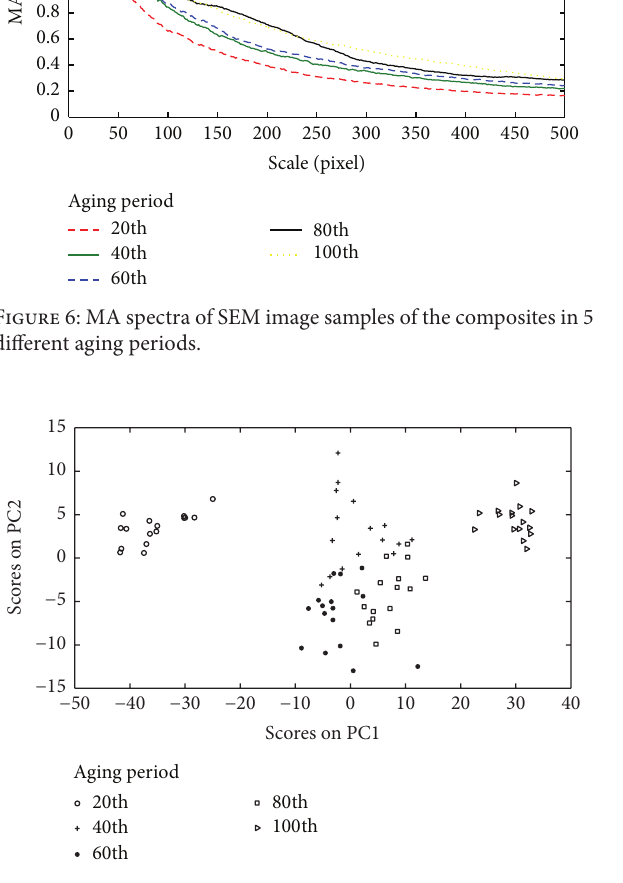
Figure 7: PCA scores plot of AMT spectra of SEM image samples of the composites in five different aging periods.